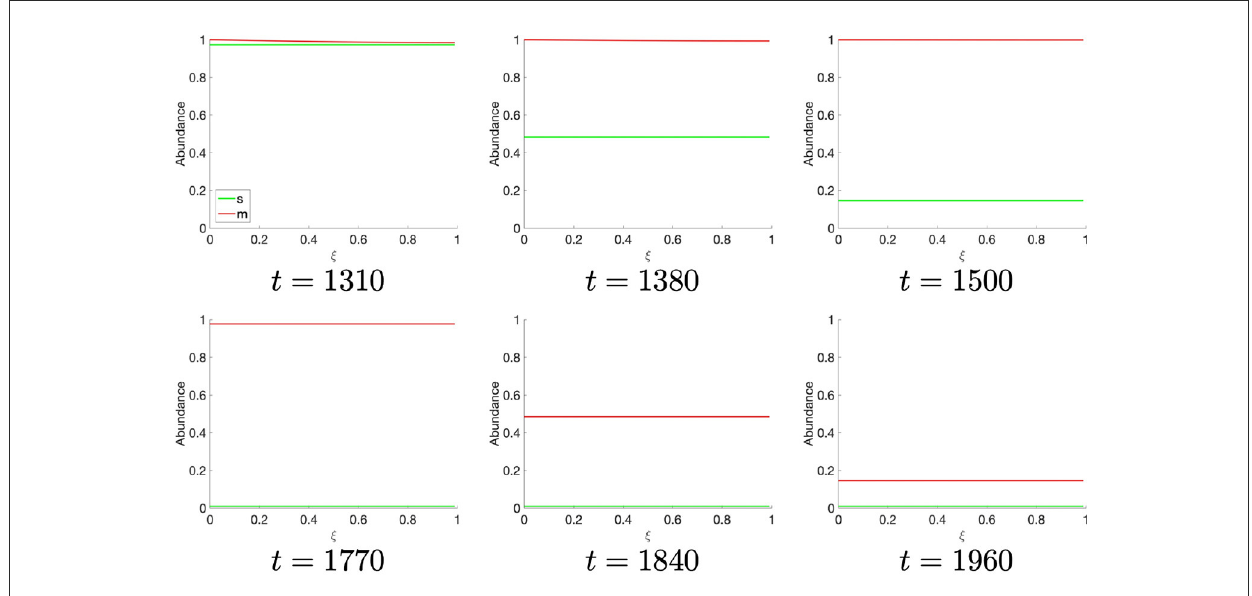
FIGURE3 Spatial S- and M-cyclin state estimated for t